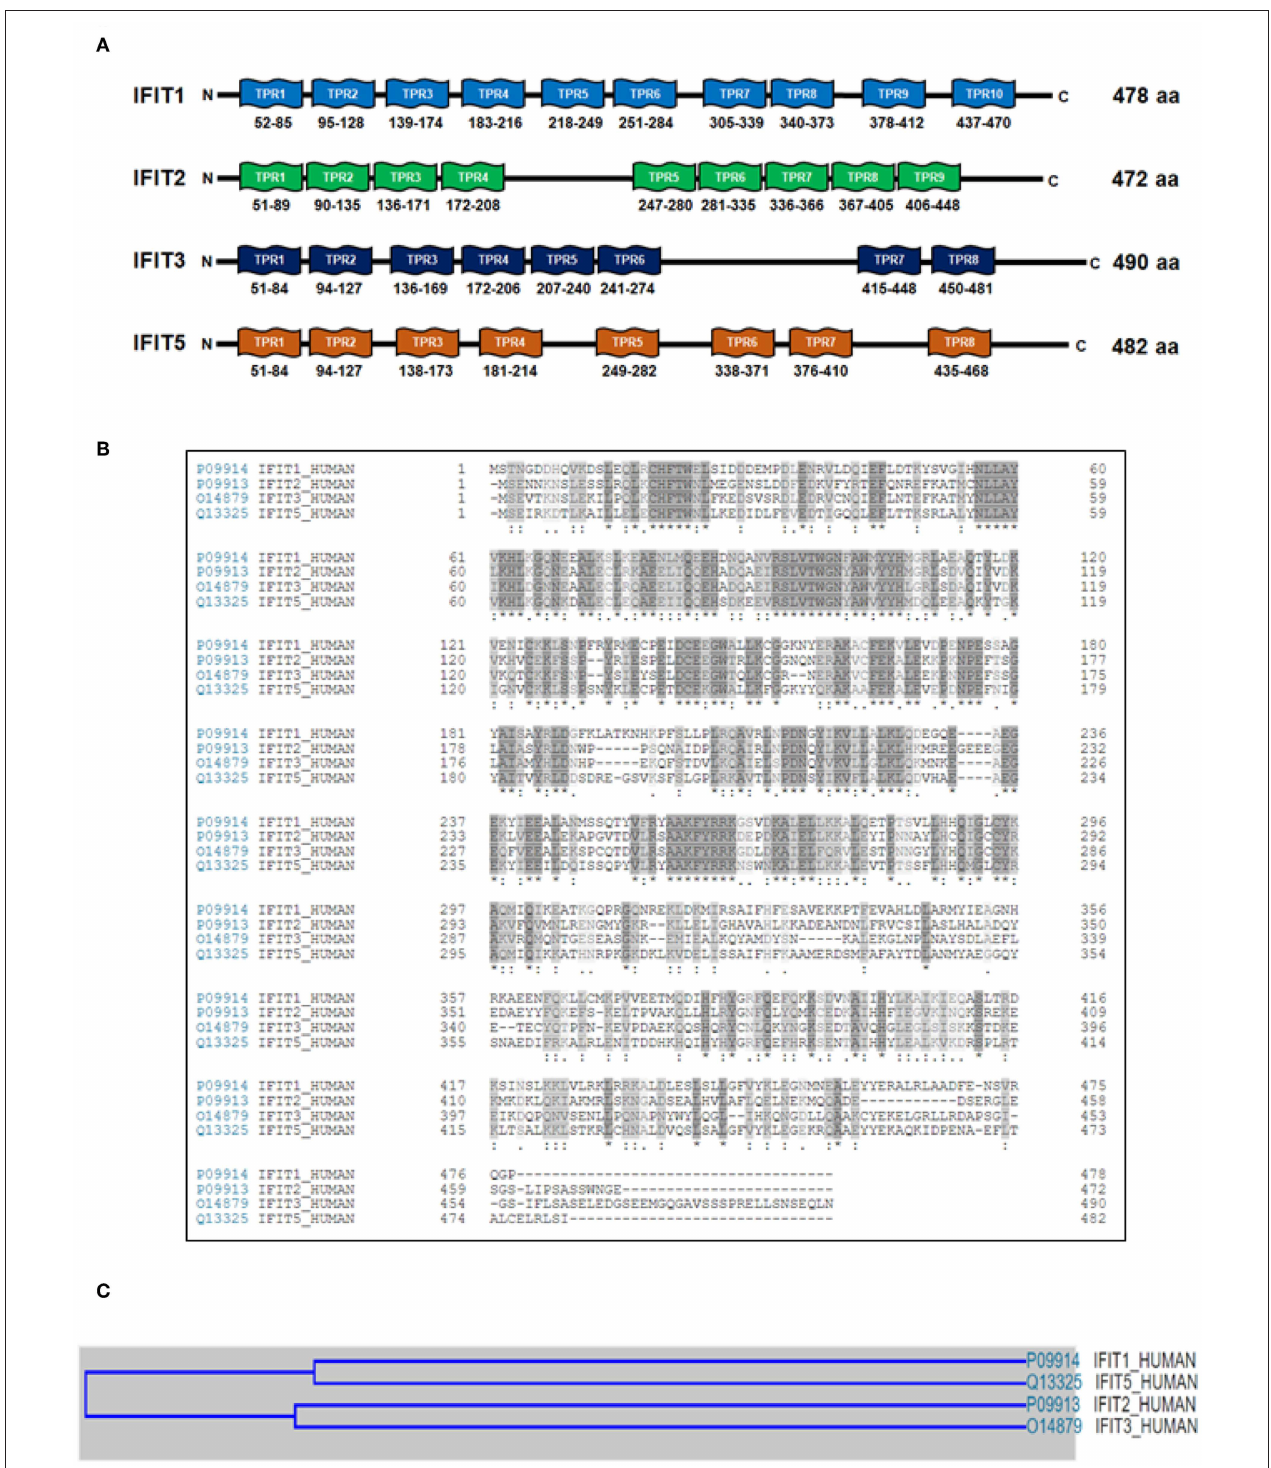
FIGURE 3 | The organization of tetratricopeptide repeat (TPR) motifs and phylogenetic analyses of human IFIT family proteins. (A) The schematic illustration shows the predicted number of TPR motifs in IFIT1 (P09914), IFIT2 (P09913), IFIT3 (O14879) and IFIT5 (Q13325) according to the UniProtKB database. The numbers are UniProtKB accession numbers. (B) Sequence alignments of human IFIT proteins with Clustal Omega. The multiple-sequence alignment shows that IFIT1, IFIT2, IFIT3 , and IFIT5 share only 25% sequence similarity. (C) The cartoon depicts the evolutionary relationship among human IFIT proteins. The multiple-sequence alignment using Clustal Omega reveals that IFIT1 and IFIT5 have 54% sequence similarity, whereas IFIT2 and IFIT3 have 52%.